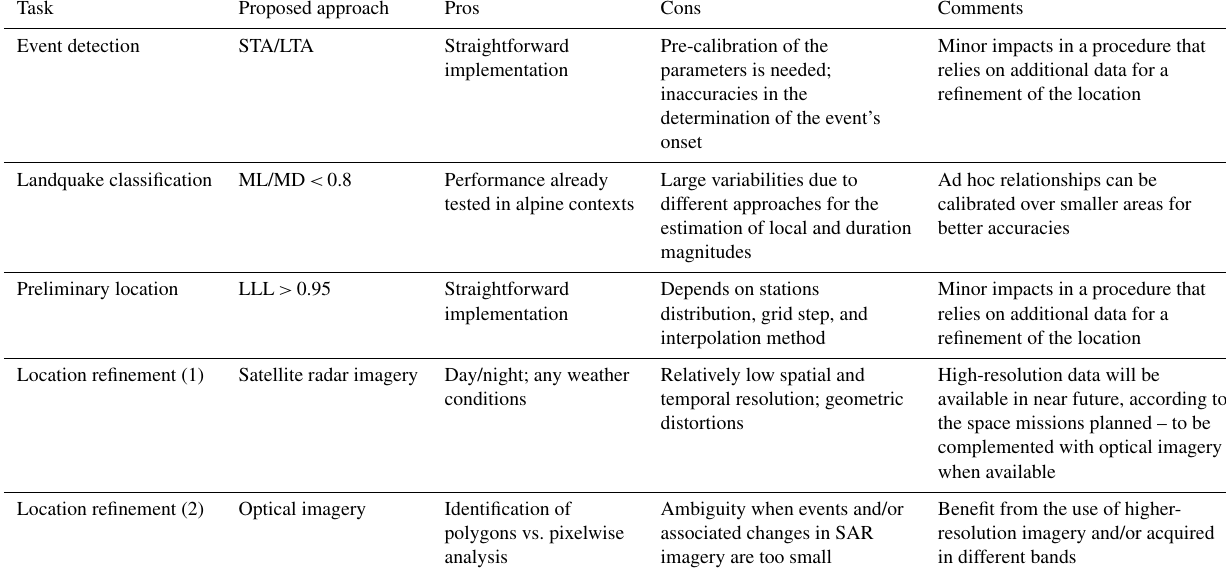
Table 3. Summary of the pros and cons related to the herein proposed strategy for landquake identification, location, and classification.